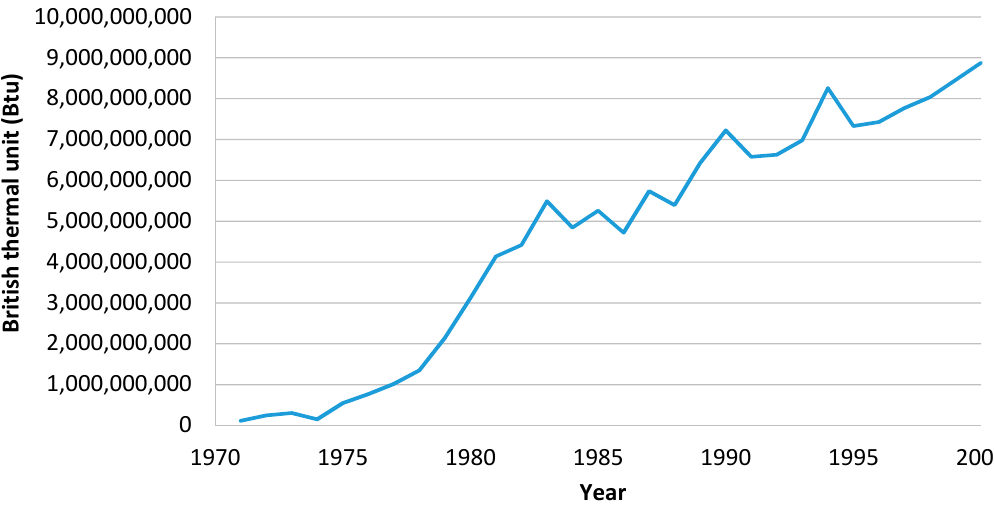
Figure 5. Natural gas for electricity production in Nigeria across 1971–2000 [32].